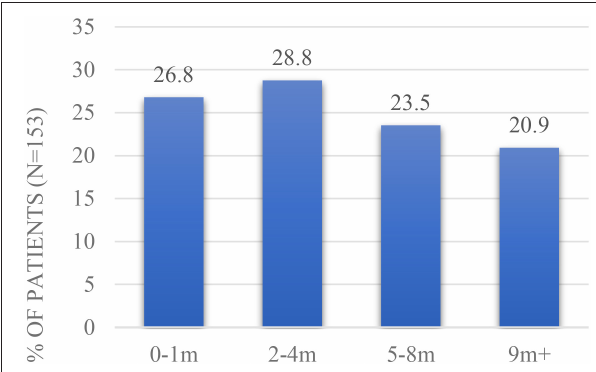
FIGURE 4 | Duration of symptoms prior to